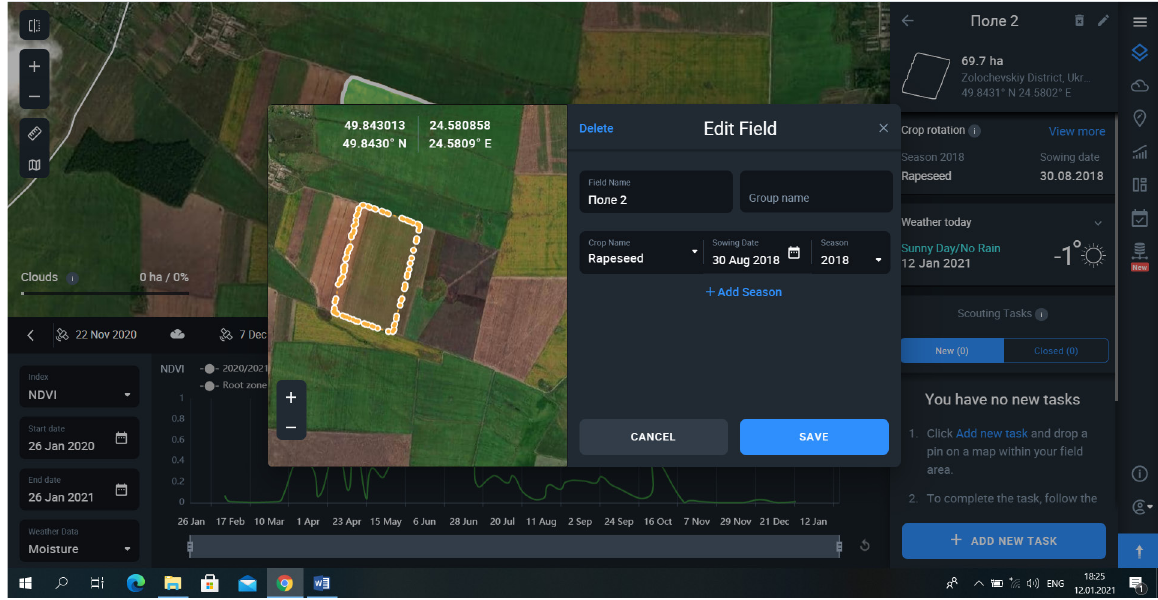
Figure 7. The reflection of the location of a neighboring area for land use object in